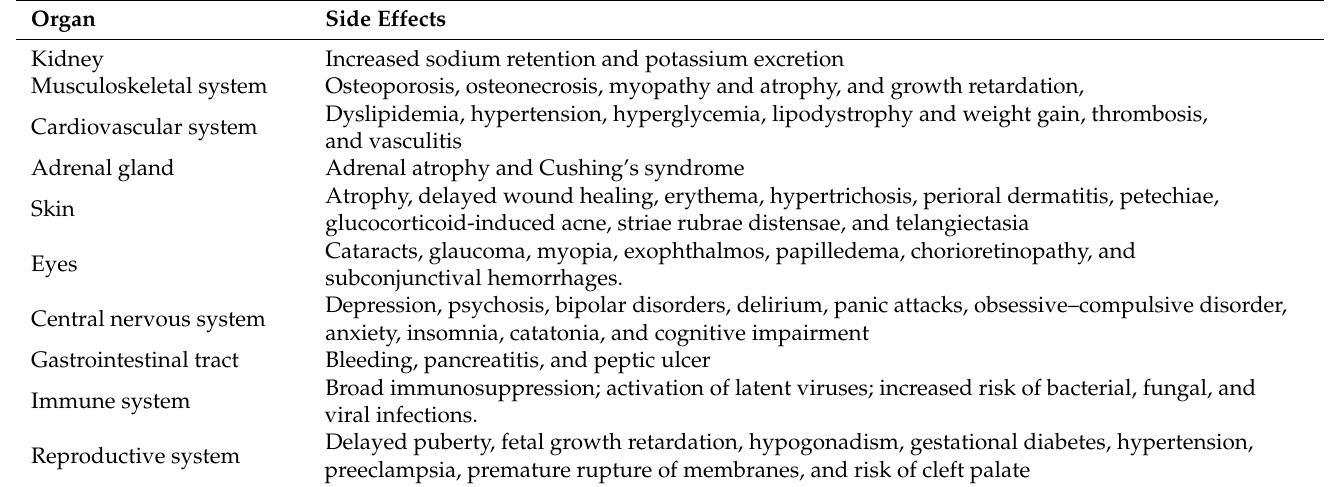
Table 3. Summary of Organ-Specific Side Effects of High-Dose or Prolonged GC